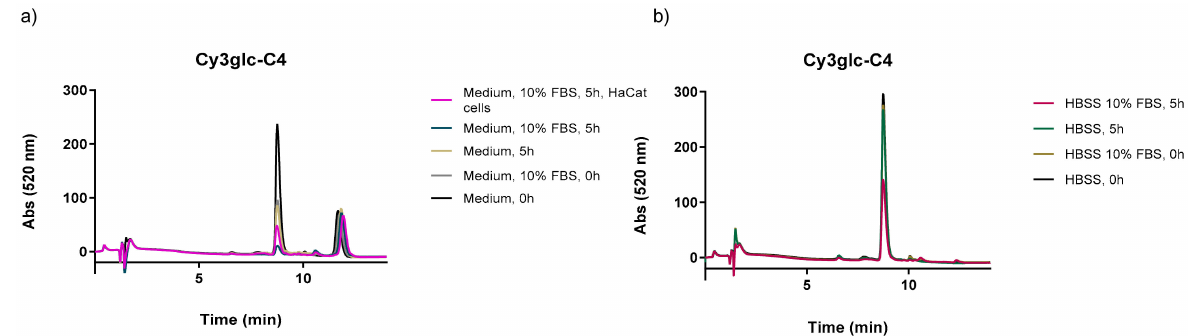
Figure 1. Physiological stability assays of Cy3glc-C4 were performed in DMEM ( a ) or HBSS ( b ), at pH 7.4 and 37 ◦ C, during 5 h. Representative chromatograms at 520 nm.